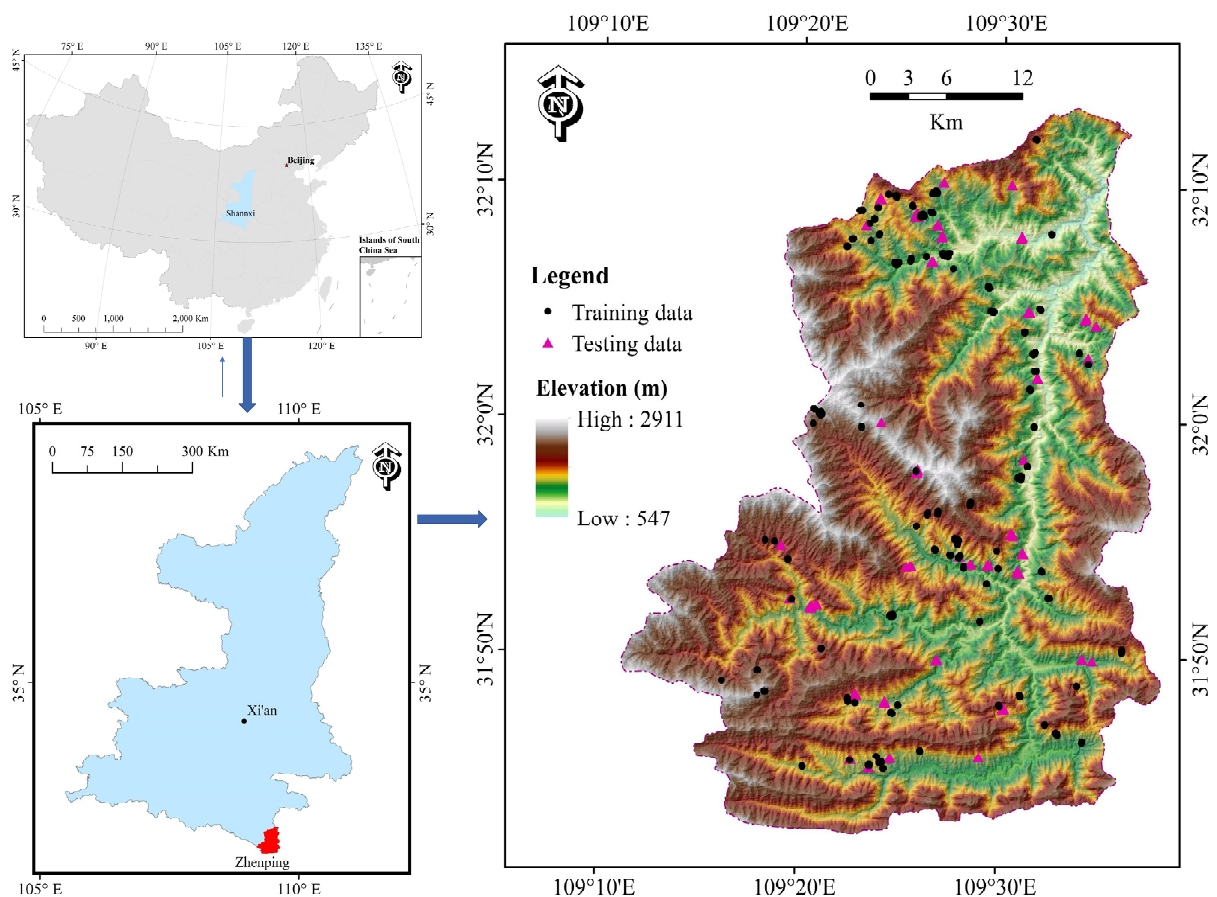
Figure 1. Location of the study area.